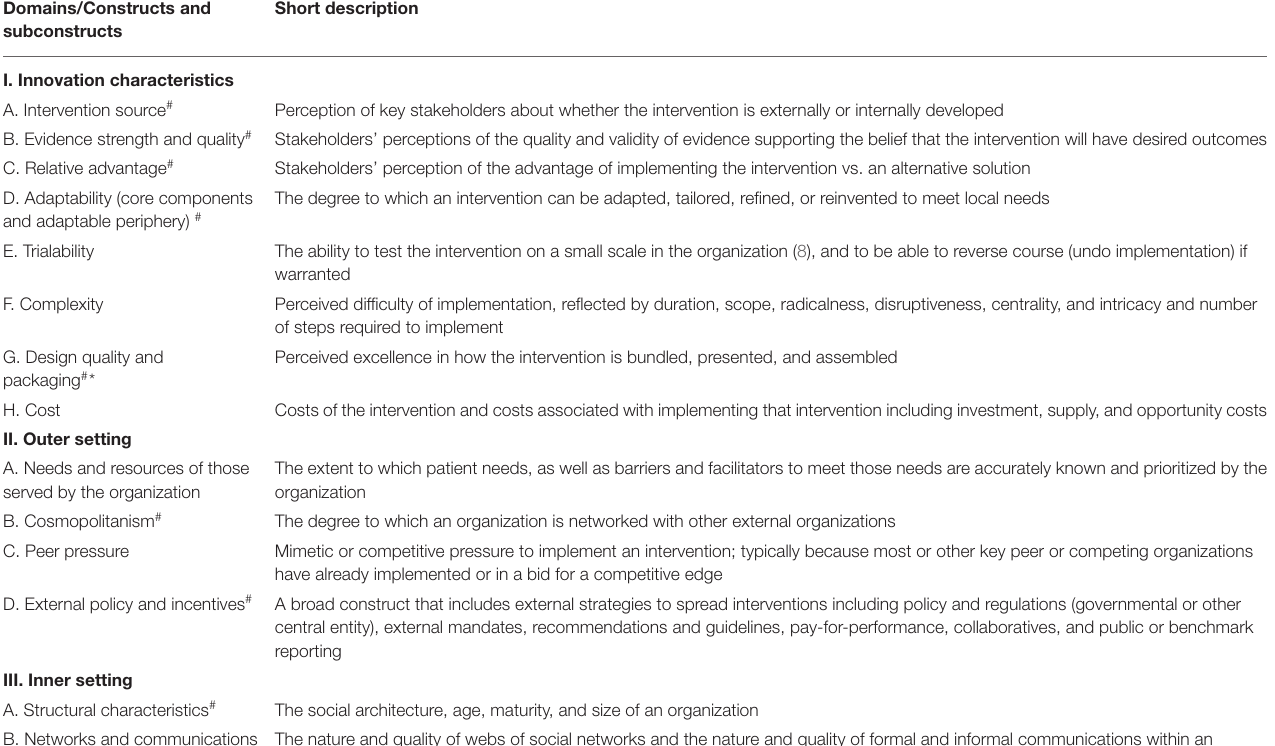
TABLE 2 | Domains and associated constructs of the consolidated framework for implementation research. Domains/Constructs and